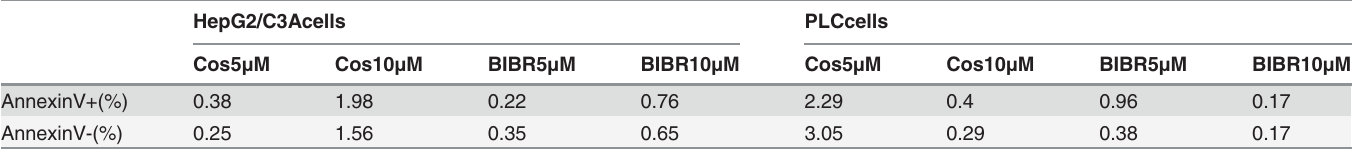
Table 1. Annexin V sorting of HepG2/C3A and